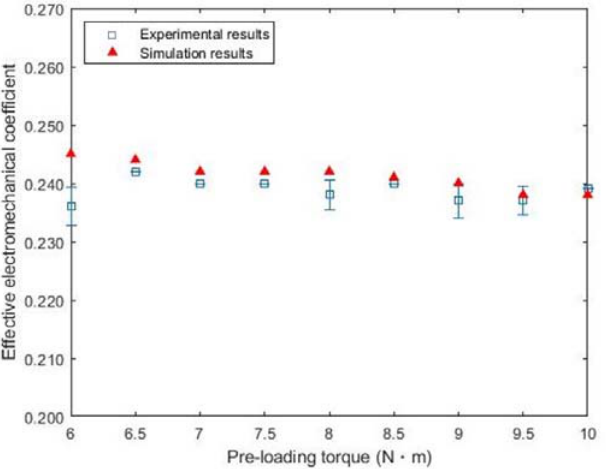
Figure 6. Simulation and experimental results regarding k eff as a function of pre ‐ load torque.